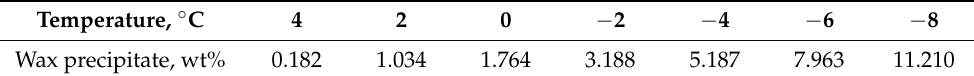
Table 2. Wax crystals precipitated from 0# diesel oil at different temperatures.